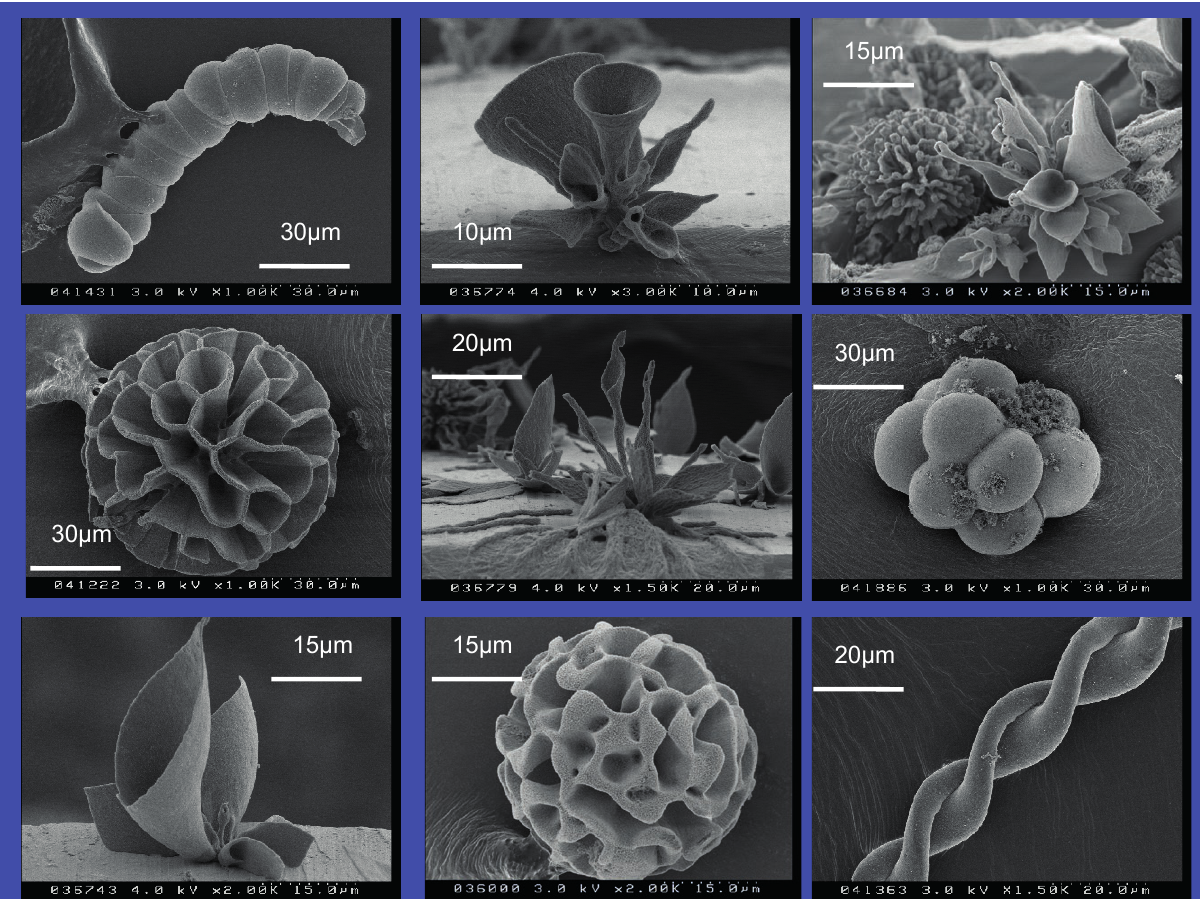
Figure 33. Field emission scanning EM images of barite crystals grown in silica gels (pH ca. 12, photo courtesy Anna